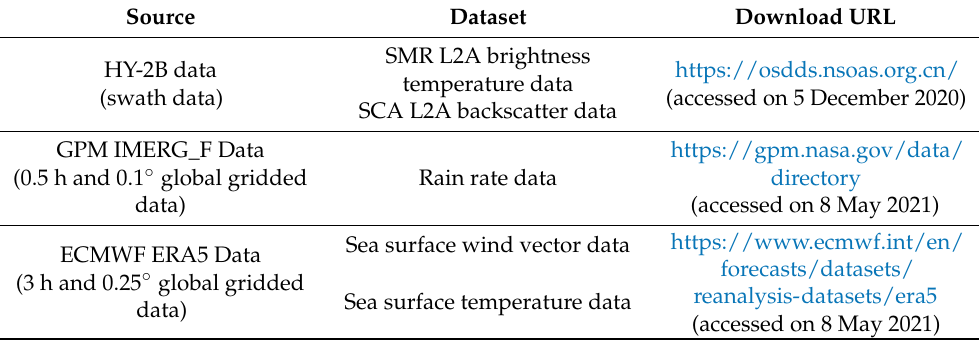
Table 2. Summary of the